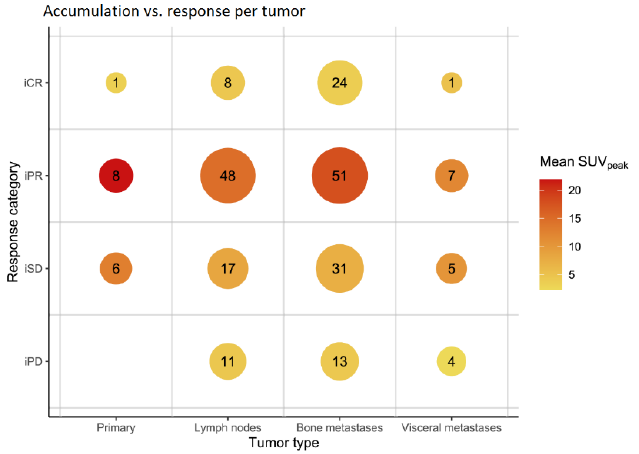
Figure 5 . Relationship between metastasis type, response, and accumulation. Numbers in the plot indicate the number of tumors in the corresponding group. Legend: iCR = Imaging complete response, iPD = Imaging progression disease, iPR = Imaging partial response, iSD = Imaging stable disease, SUV = Standardized uptake value.